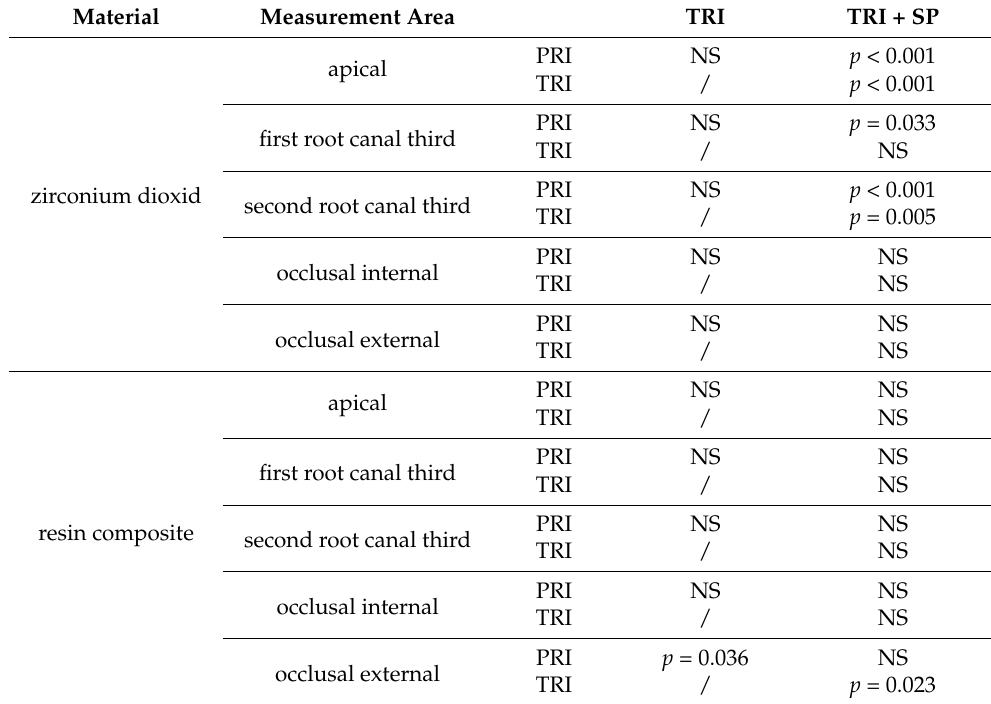
Table 4. p -values of pairwise comparison ( p -value < 0.05, NS = not significant) of the linear dis- crepancies ( µ m) distributed to the five measurement areas for fabricated CAD/CAM-P+C milled of zirconium dioxid and resin composite based on digital impressions with IOS (PRI = Primescan, TRI = Trios 4, and TRI+SP = Trios 4 and